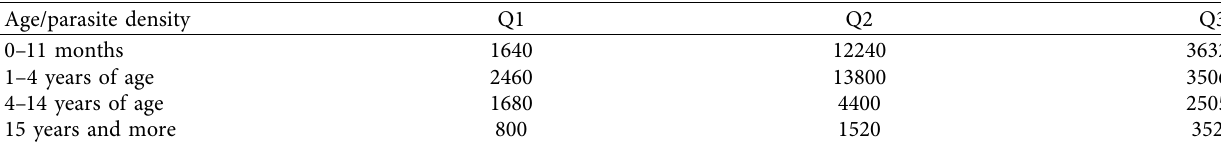
Table 5: Dispersion around the mean of the parasite densities for each age